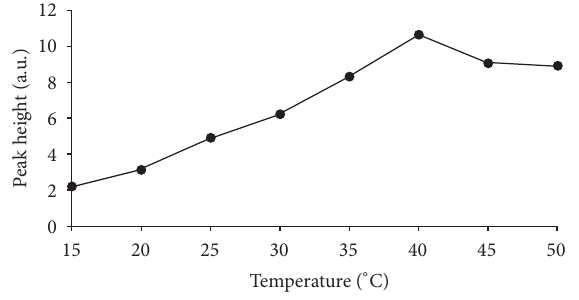
F 6: Effect of sample loop volume on the sensitivity. Con- ditions: 0.5M hydrochloric acid, 2